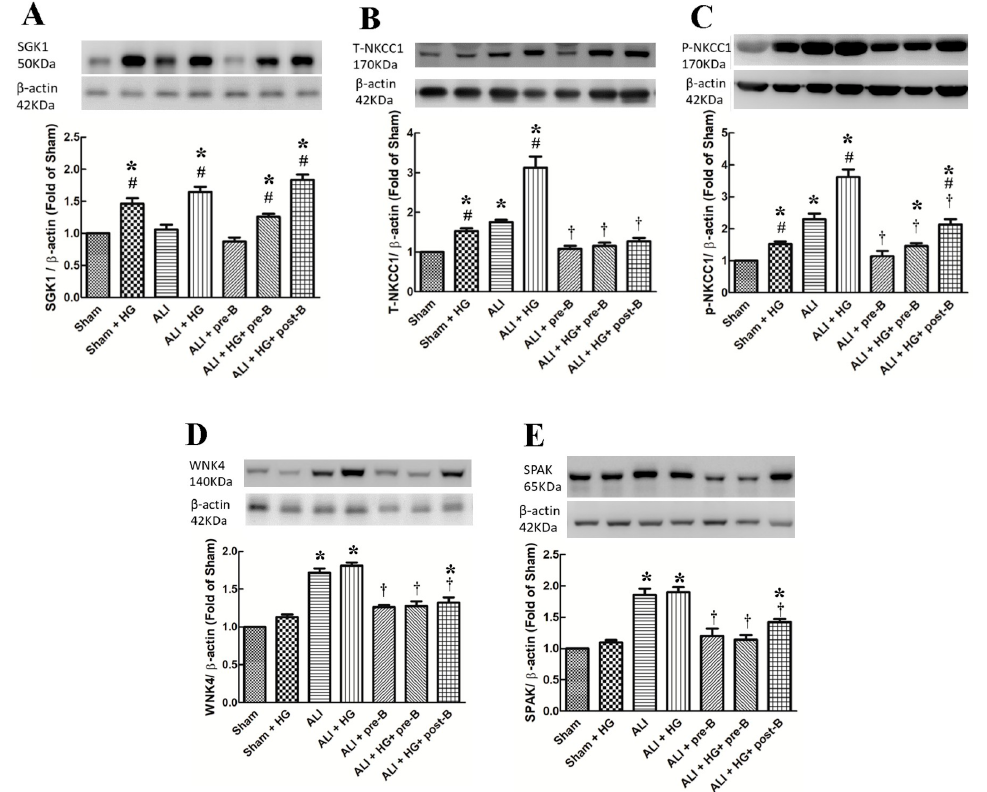
Figure 6. Effects of hyperglycemia and NKCC1 inhibitor treatment on the levels of SGK1, NKCC1, WNK4 and SPAK. The levels of SGK1 ( A ) were significantly higher in hyperglycemic rats than in non-hyperglycemic rats ( p < 0.05). High levels of T-NKCC1 ( B ) and p-NKCC1 ( C ) were observed in the ALI group, which increased further in the ALI + HG group ( p < 0.05). The NKCC1 expression was lower in the rats of ALI + pre-B, ALI + HG + pre-B and ALI + HG + post B ( p < 0.05). The levels of WNK4 ( D ), and SPAK ( E ) were higher in rats of ALI and ALI + HG ( p < 0.05) and decreased in the rats of ALI + pre-B, ALI + HG + pre-B and ALI + HG + post B ( p < 0.05). *Significant difference, as compared to the sham group ( p < 0.05), # Significant difference, comparing the groups with HG to those without HG (I vs. II, III vs. IV, V vs. VI, and V vs. VII, p < 0.05), † Significant difference, comparing the ALI groups with B to those without B (III vs. V, IV vs. VI, and IV vs. VII, p < 0.05). Abbreviation: ALI = acute lung injury, SGK1 = serum-glucocorticoid kinase 1, T-NKCC1 = total sodium-potassium-chloride co-transporter one, p-NKCC1 = phosphorylated sodium-potassium-chloride co-transporter one, WNK4 = with-no-lysine kinases 4, SPAK = STE20/SPS1-related proline/alanine-rich kinase, HG = hyperglycemia, pre-B = pretreatment with bumetanide, post-B = post-treatment with bumetanide.